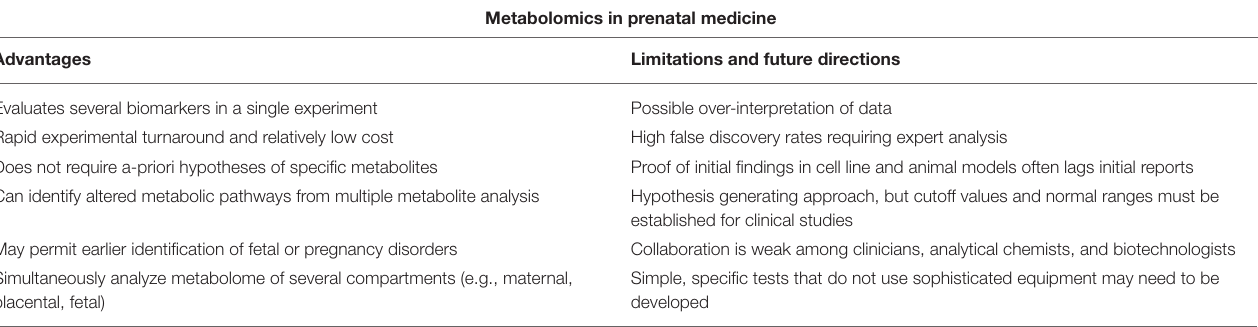
TABLE 3 | Advantage, limitations, and the future of metabolomics in prenatal